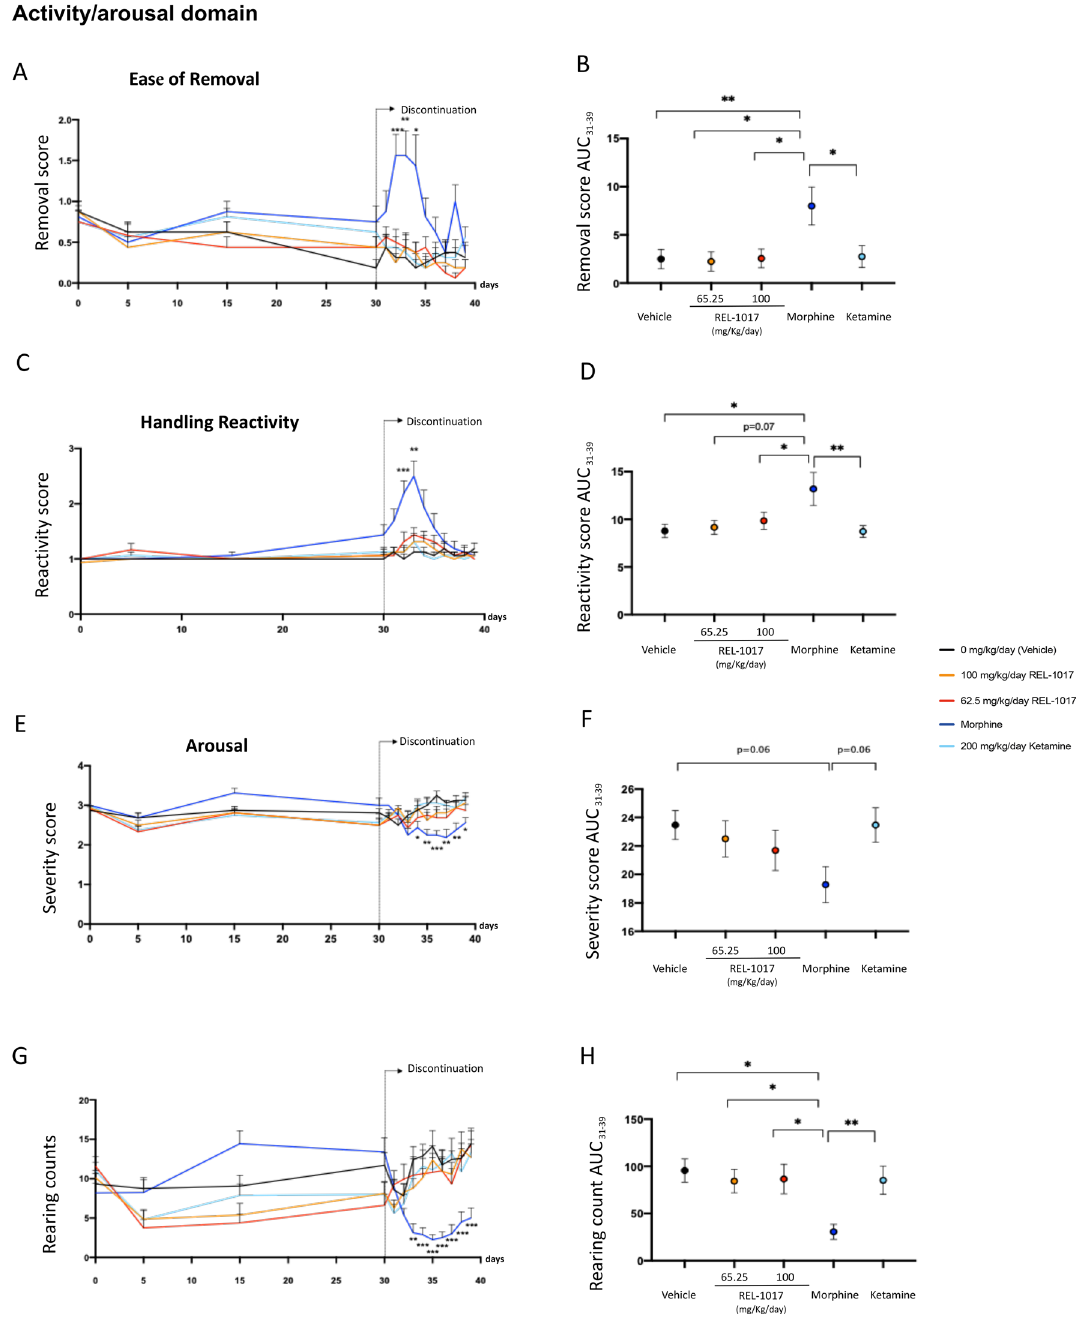
Figure 4. Discontinuation of chronic REL-1017 (esmethadone) administration did not cause modification in measures of excitability. Following cessation after 30 consecutive days of drug administration, measures of excitability, including ease of removal ( A ), handling reactivity ( C ), arousal ( E ), and rearing counts ( G ) were significantly different in morphine-treated rats (dark blue line) compared to vehicle (black line) and REL-1017- treated rats (yellow and red lines; *p < 0.05; **p < 0.01; ***p < 0.001; ****p < 0.0001). Area under the curve (AUC) values of ease of removal ( B ), handling reactivity ( D ), arousal ( F ), and rearing counts ( H ) were measured over the time interval 31–39 days. AUCs of morphine-treated rats (blue dot) were statistically different compared to AUCs of vehicle (black dot) and REL-1017- treated rats (yellow and red dots; *p < 0.05; **p < 0.01; ***p < 0.001; ****p <